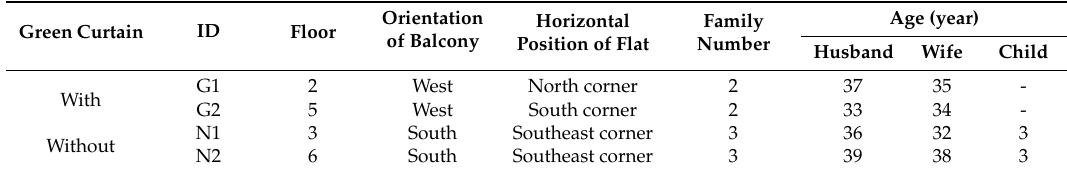
Table 2. The profile of investigated households.